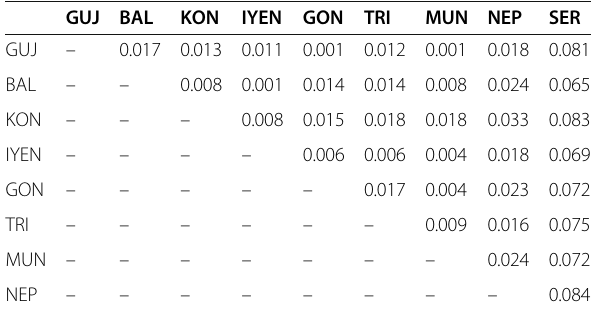
Table 7 F ST values among nine populations based on the same set of 15 STR markers